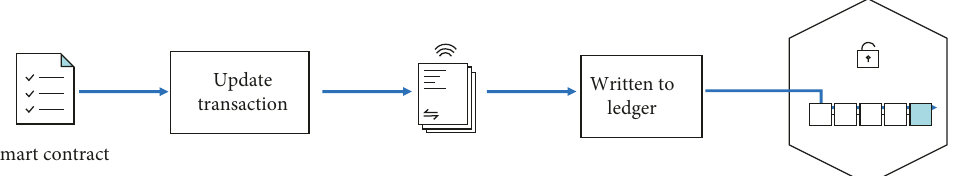
Figure 7: Process of smart